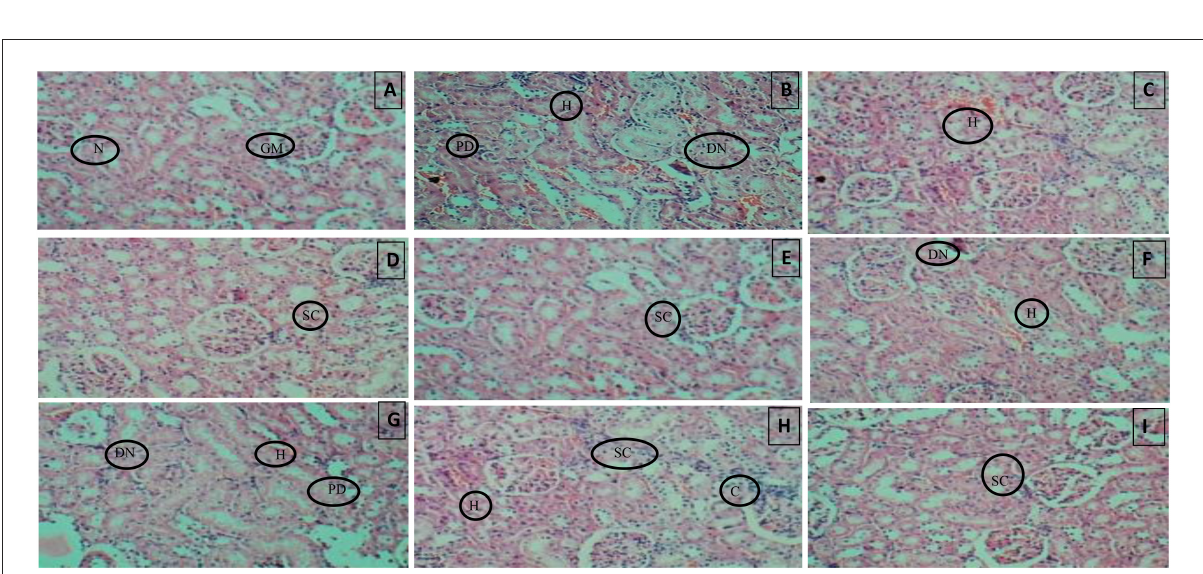
FIGURE10 (A) Normal control, (B) Diseased, (C) Pioglitazone 3.98 mg/kg, (D) Metformin 44.29 mg/kg, (E) Glimepiride 0.18 mg/kg, (F) Acarbose 8.86 mg/kg, (G) B. aurea 100 mg/kg, (H) B. aurea 200 mg/kg, and (I) B. aurea 400 mg/kg. Note: N, Nephron; GM, Glomerulus; P, Proximal tubule; PD, Proximal tubule damage; H, Hemorrhage; DN, Denatured nephron; SC, Suffused capillaries; C, Congestion of capillaries at Bowman’s capsule.